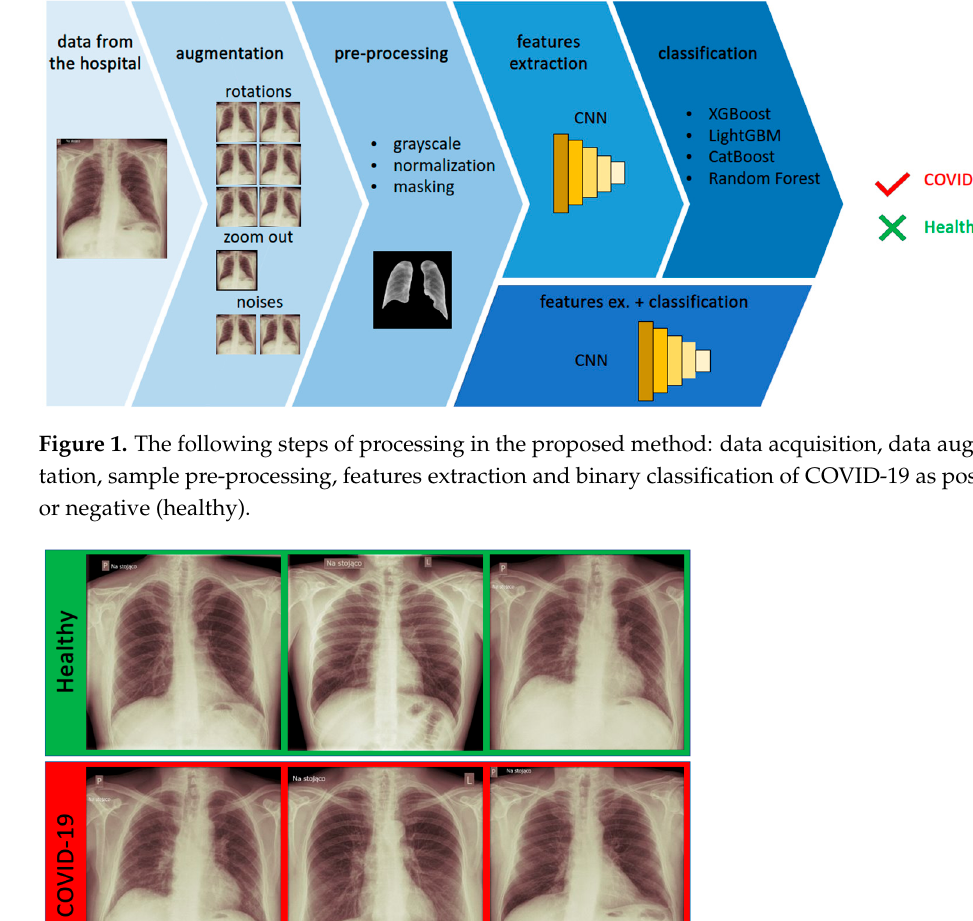
Figure 1. The following steps of processing in the proposed method: data acquisition, data augmentation, sample pre-processing, features extraction and binary classification of COVID-19 as positive or negative (healthy).